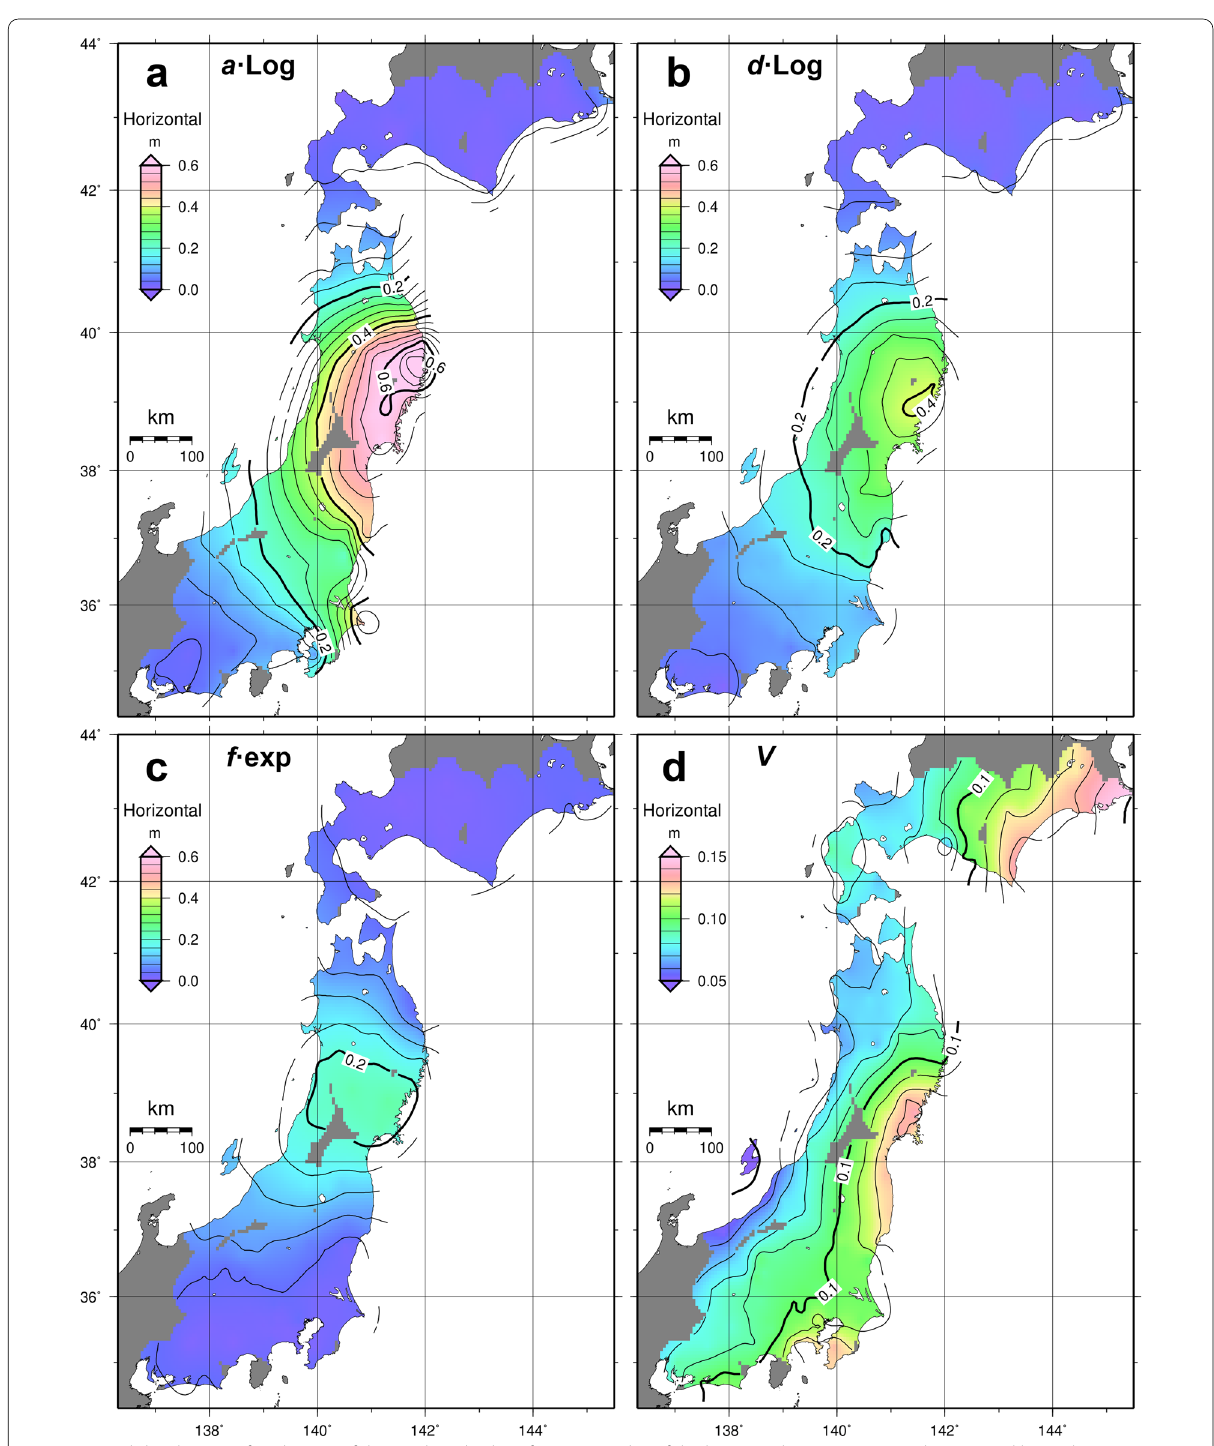
Fig. 8 Spatial distribution of each term of the predicted values for magnitudes of the horizontal components. a Short-period logarithmic term, b long-period logarithmic term, c exponential term, and d linear velocity term Vt in Eq. (4). The values for each term represent the distribution for three years after the earthquake (March 11, 2014), with values immediately after the earthquake set to